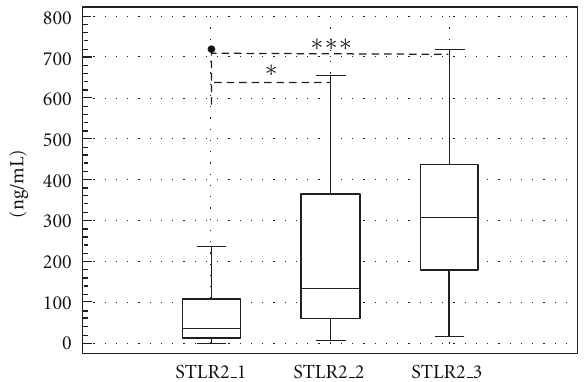
Figure 2: The concentration of soluble TLR2 (ng/mL) in pleural e ff usion fluid at three sampling points: 1—before thoracoscopic procedure, 2—2 hours after terminating talc insu ffl ation procedure, 3—24 hours after talc insu ffl ation procedure. (Line: median; boxes: quartiles; whiskers: nonoutliers range.) Significance: ∗ P = 0,05–